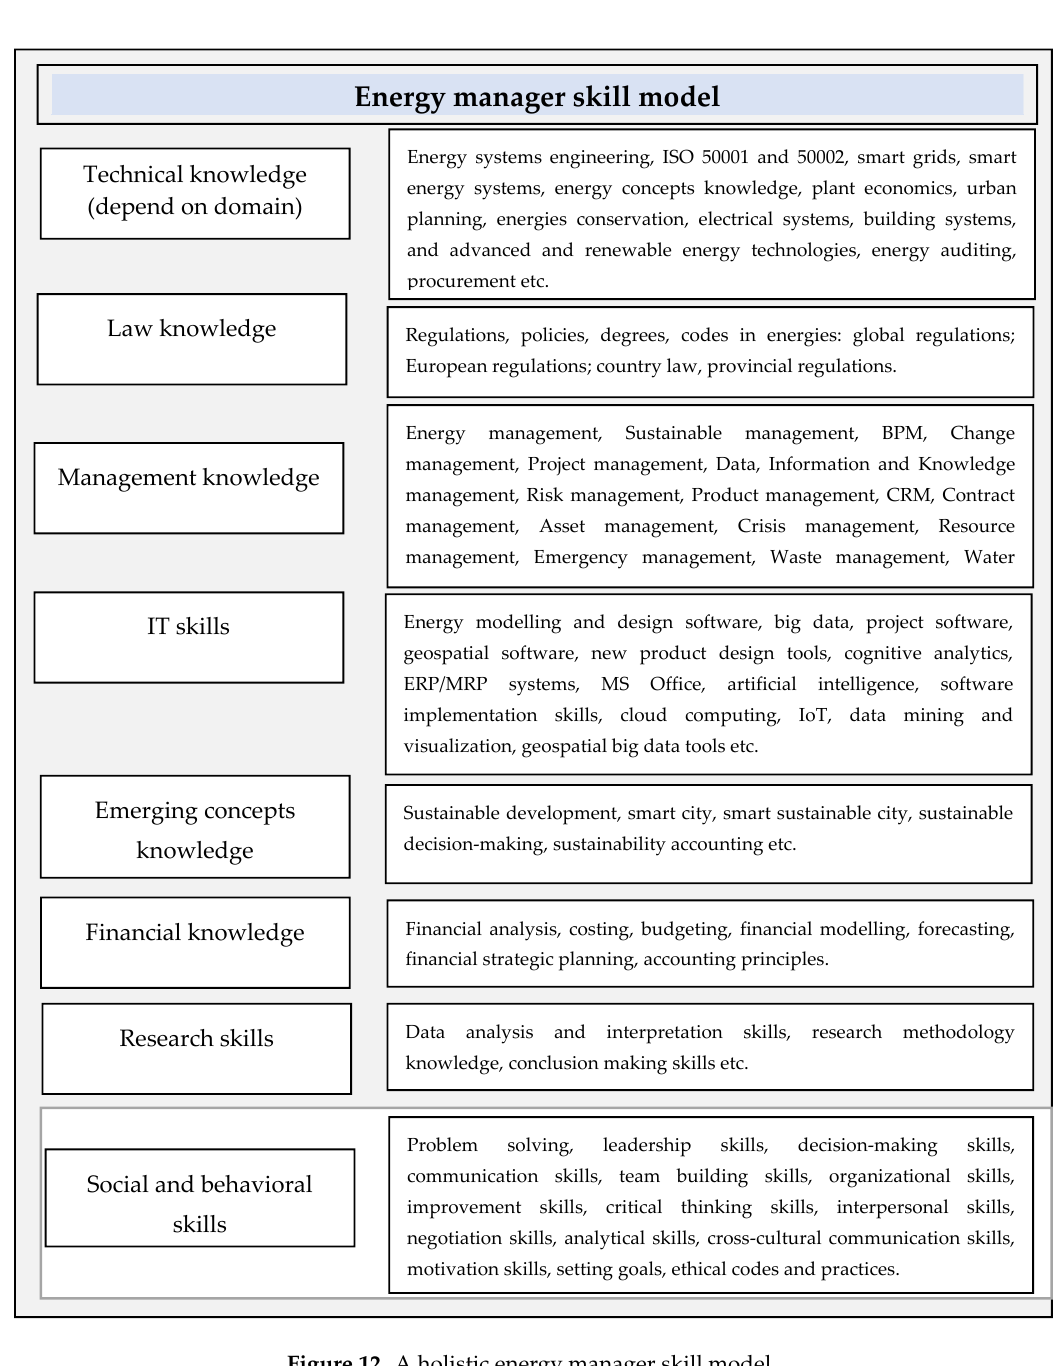
Figure 12. A holistic energy manager skill model.